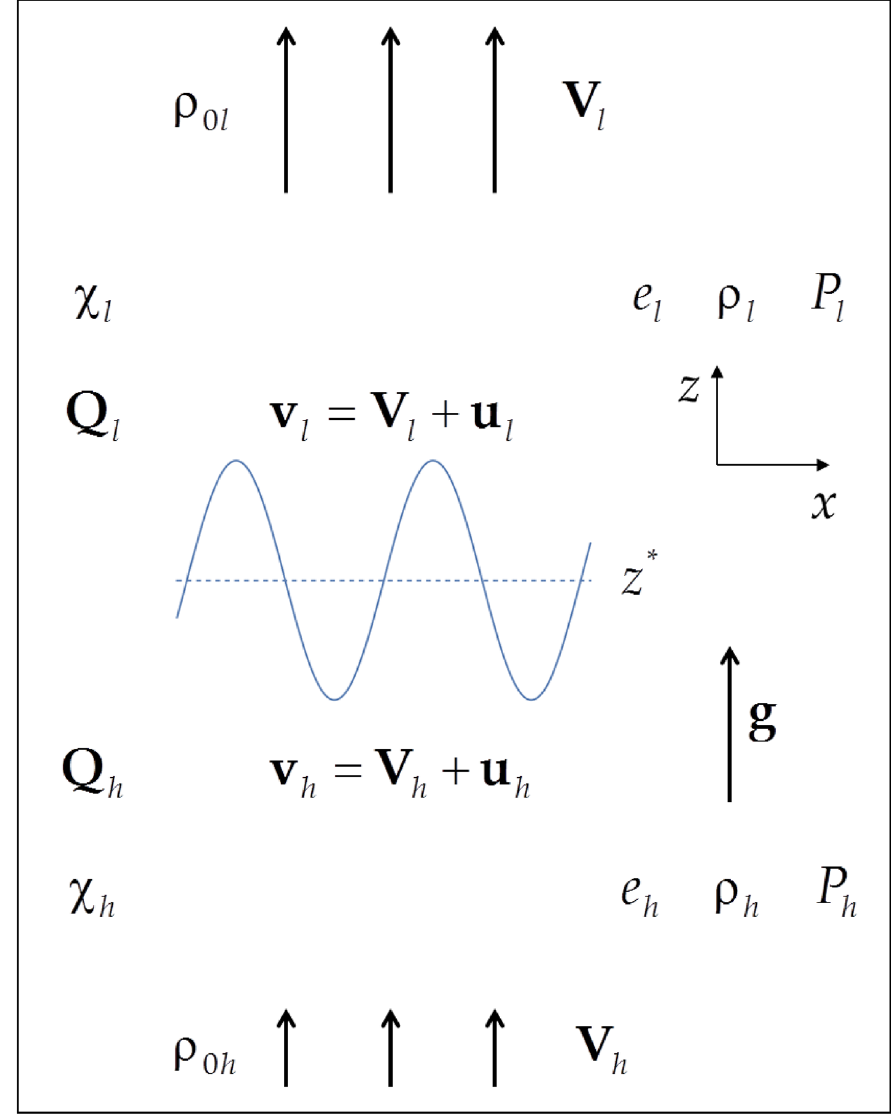
Fig. 1 Schematics of the dynamics (in a far field, not to scale). Blue color marks the planar interface (dashed line) and the perturbed interface (solid line)